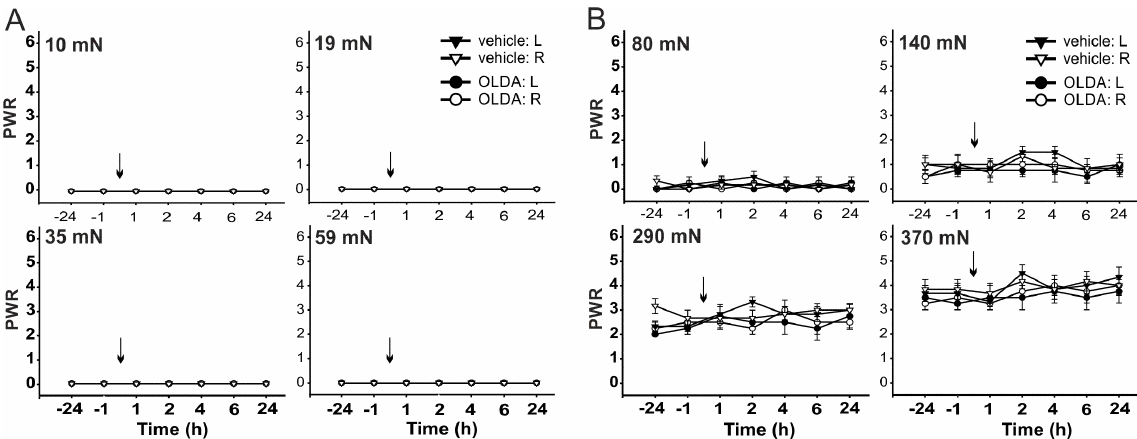
Figure 3. Paw withdrawal responses (PWRs) to mechanical stimulation remained unaffected by intrathecal administration of TRPV1 endogenous agonist OLDA. Administration of OLDA (0.42 µg, n = 4) did not change the PWRs evoked by von Frey filaments with bending forces of small intensities ranging from 10 mN to 59 mN ( A ), and stronger intensities ranging from 80 mN to 370 mN ( B ) when compared to vehicle treatment ( n = 6). Data represent the mean ± S.E.M. of 4 and 6 independent experiments. The time of the i.t. administration is marked by